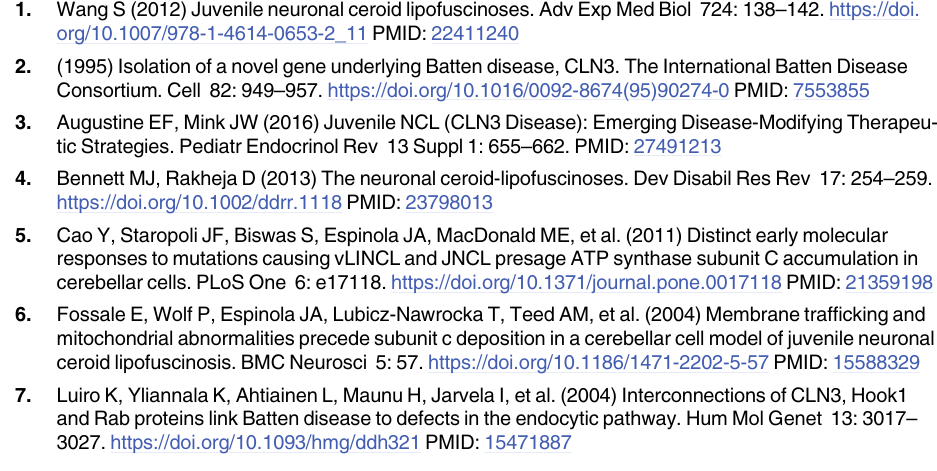
S5 Table. Significant canonical pathways in (a) male and (b) female Cln3 Δ ex7/8 mice. p- value < 0.05 is considered statistically